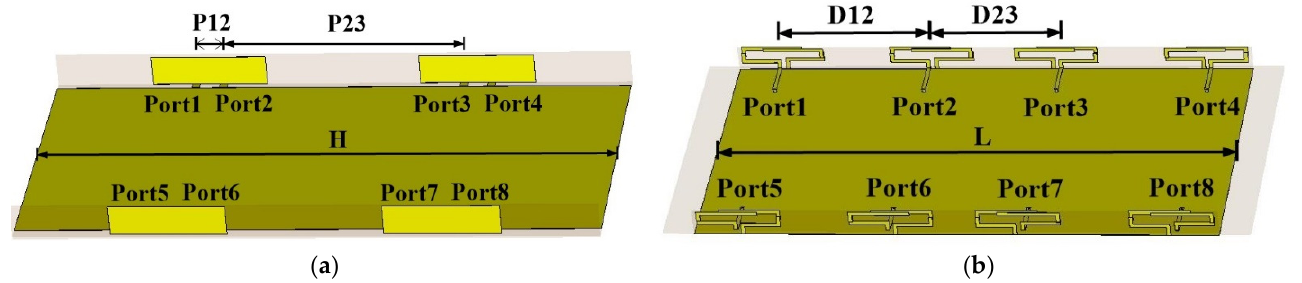
Figure 5. Perspective views of two types of terminal MIMO antennas. ( a ) Self-decoupled MIMO antenna for mobile terminals [17]. Detailed dimensions: 𝐻 = 150 mm , 𝑃12 = 7.2 mm , 𝑃23 = 62.8 mm ; ( b ) Wideband MIMO antenna systems for mobile terminals [22]. Detailed dimensions: 𝐿 = 134 mm , 𝐷12 = 39 mm , 𝐷23 = 34.5 mm . More detailed antenna parameters can be found in [17,22].